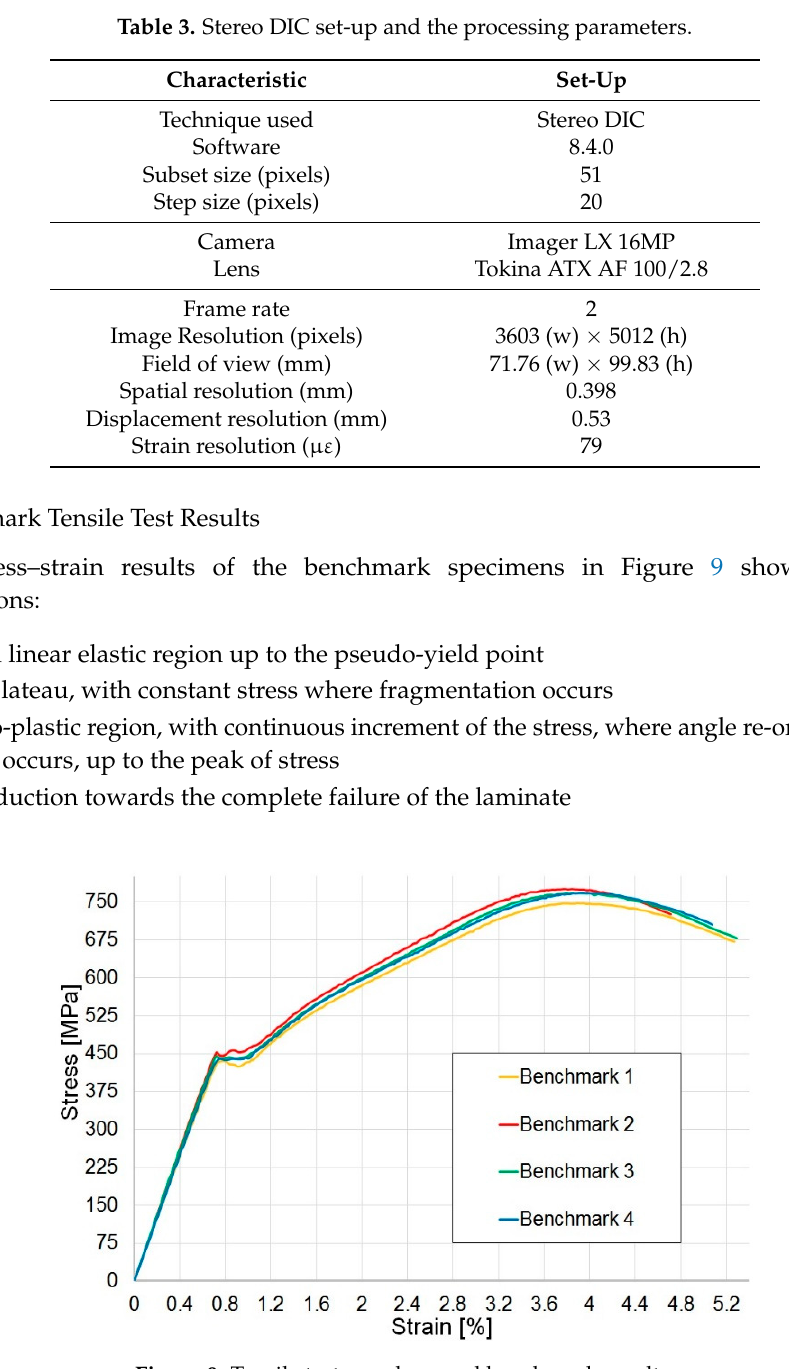
Figure 9. Tensile tests: undamaged benchmark results.